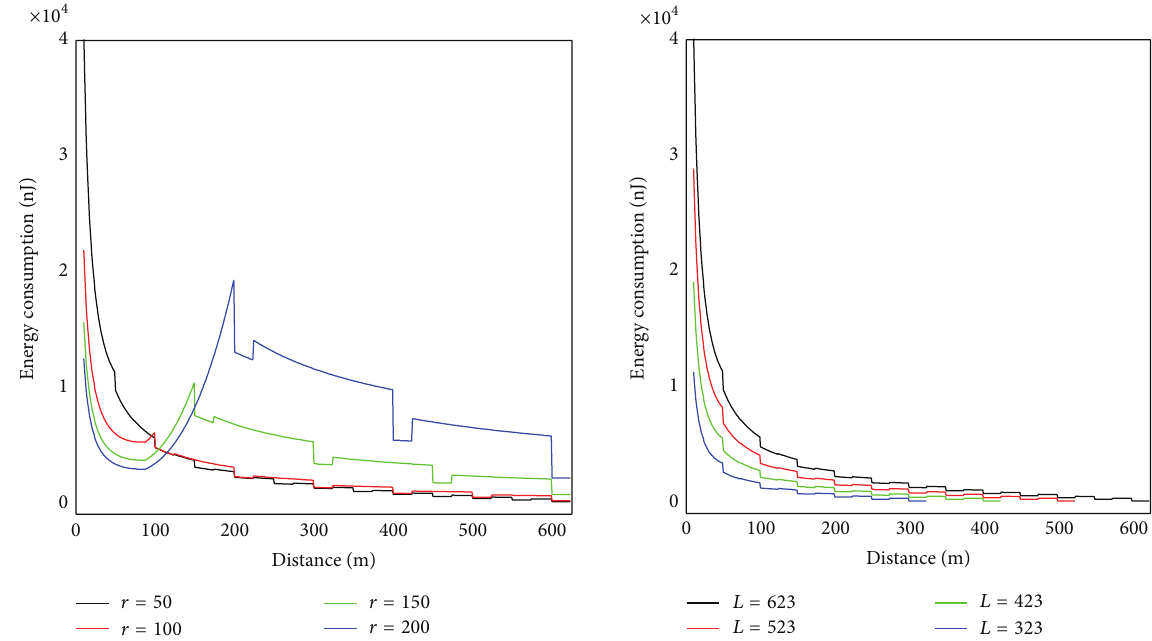
Figure 12: The relationship between energy consumption and 𝑟 .